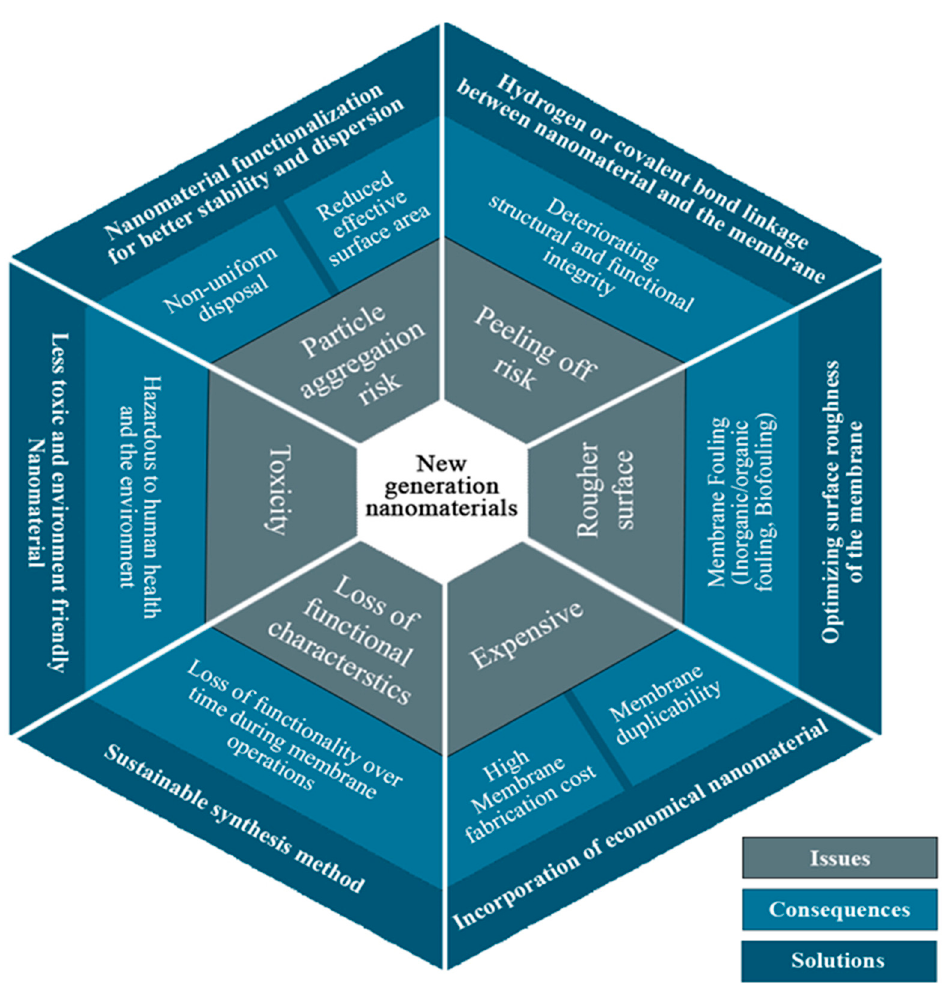
Figure 12. Summarization of serious issues related to the manufacture of nanomaterial-based polymeric MD membranes.